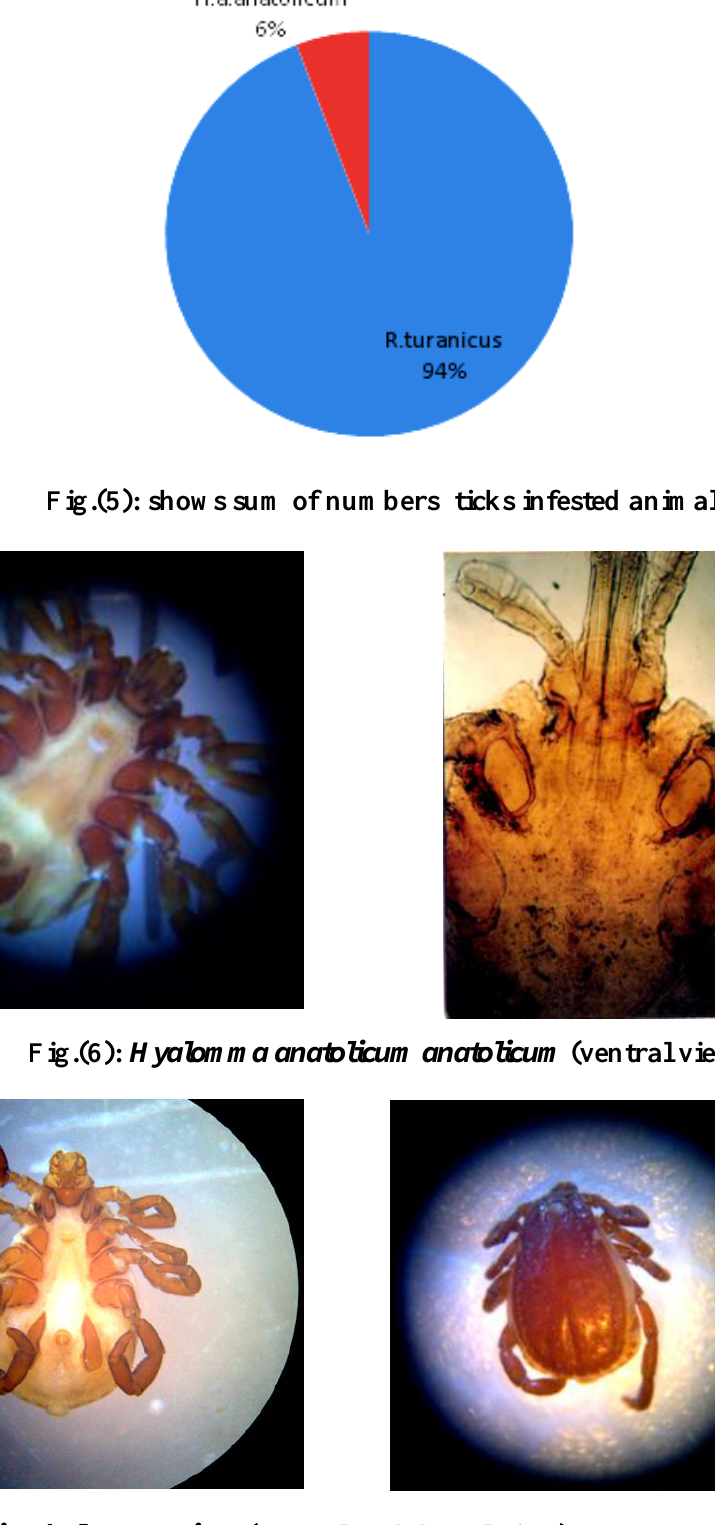
Fig. (7): Rhipicephalus turanicus (ventral and dorsal